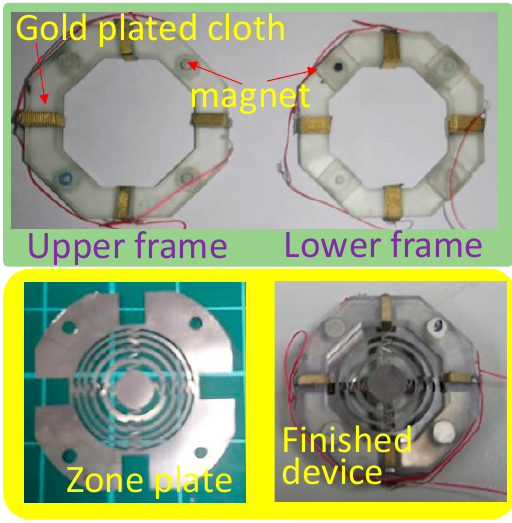
Figure 6. Fabrication results of the proposed device.